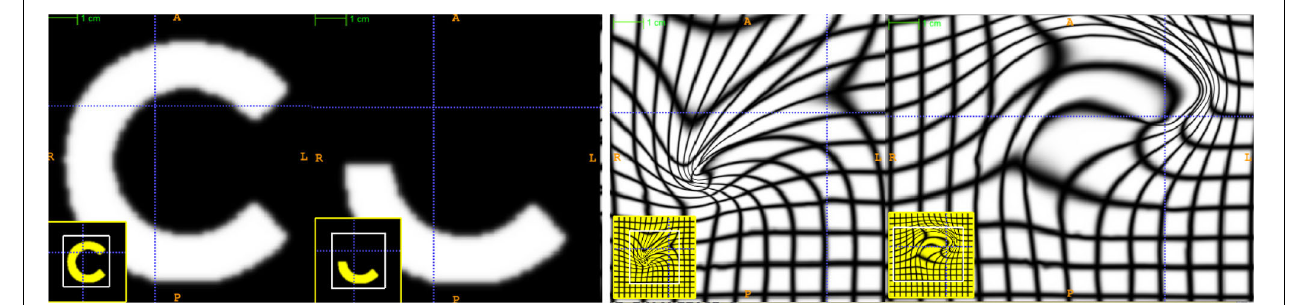
FIGURE 3 | An ITK diffeomorphic mapping of the type I (cid:3) J . The “C” and 1/2 “C” example illustrate the large deformations that may be achieved with time varying velocity fields. In this case, the moving (deforming) image is the 1/2 “C.” The right panels illustrate the deformed grid for the transformation of the “C” to 1/2 “C” (middle right) and its inverse mapping (far right) which takes the 1/2 “C” to the reference space. The unit time interval is discretized into 15 segments in order to compute this